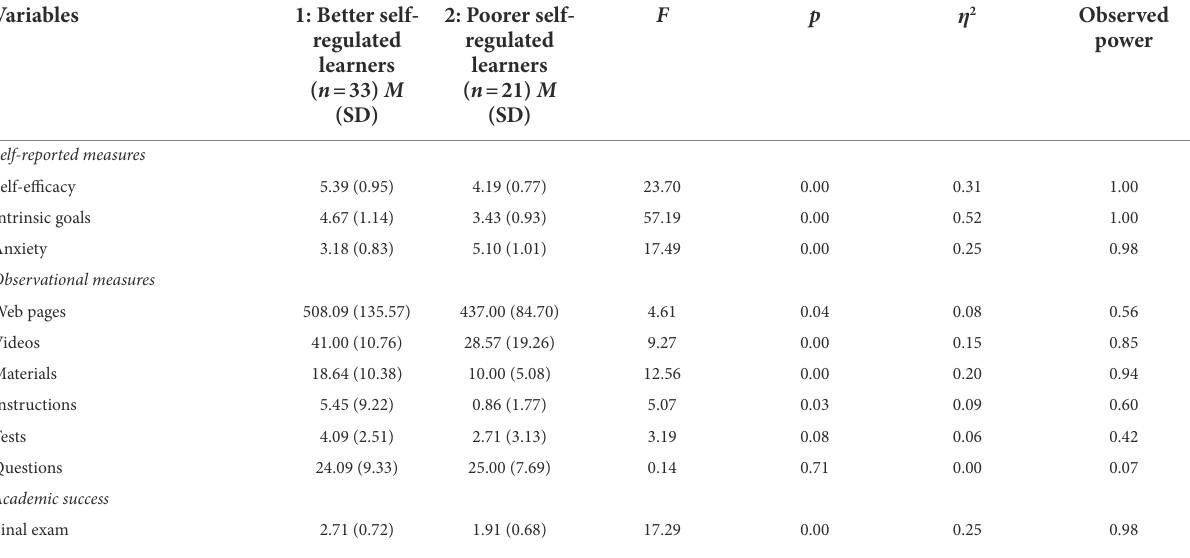
TABLE 3 Hierarchical cluster analysis using the self-reported questionnaire.